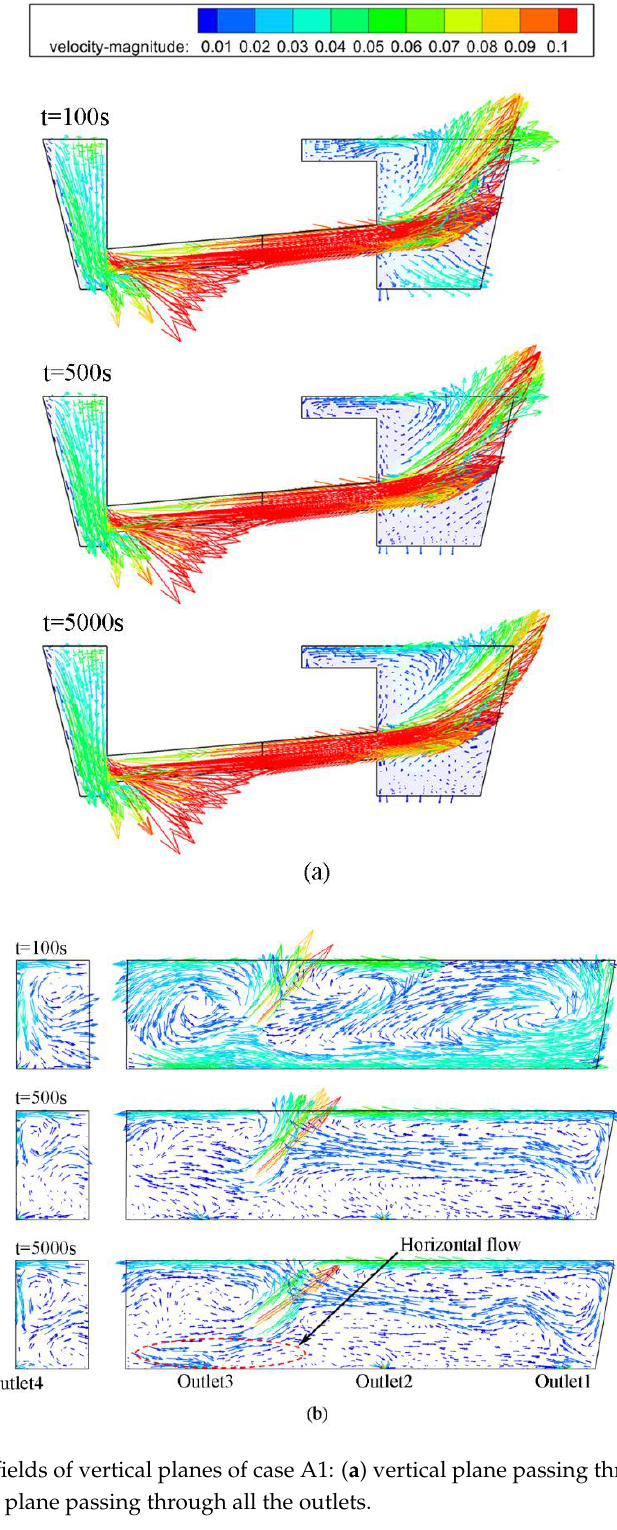
Figure 16. Velocity fields of vertical planes of case A1: ( a ) vertical plane passing through the center of channel; ( b ) vertical plane passing through all the outlets.